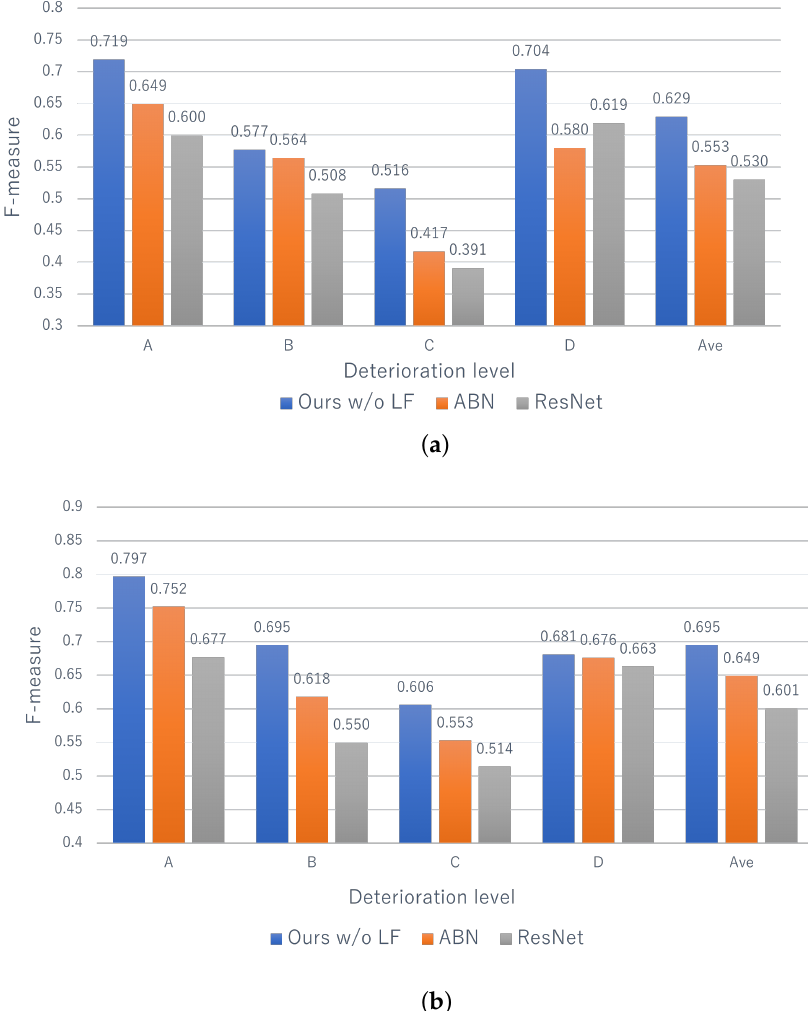
Figure 5. The estimation results for each image. Ours w/o LF means the proposed method without the late fusion. ( a ) Efflorescence and ( b ) Crack.